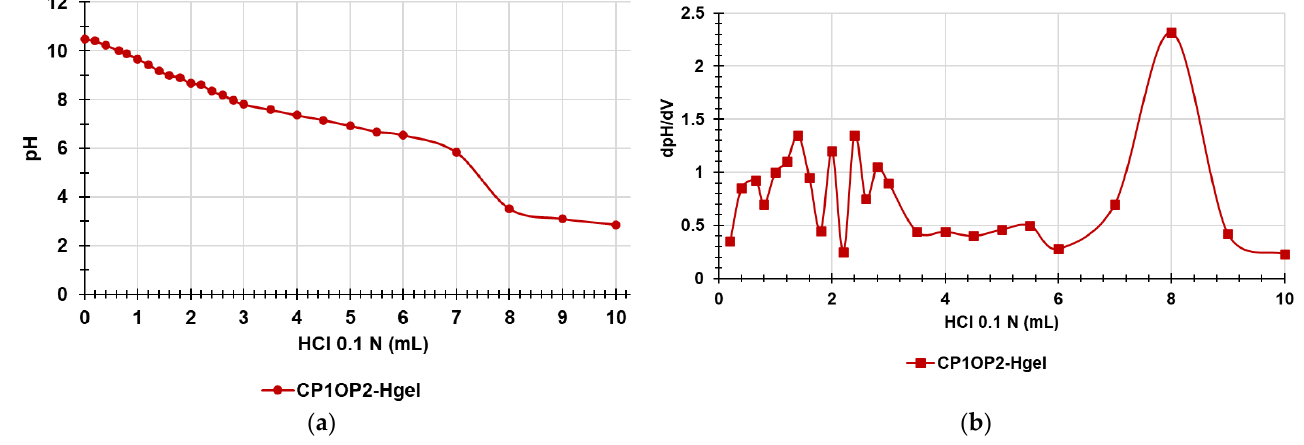
Figure 11. A representative potentiometric titration of CP1OP2-Hgel ( a ); first derivative (dpH/dV) of the curve in Figure 11a ( b ).